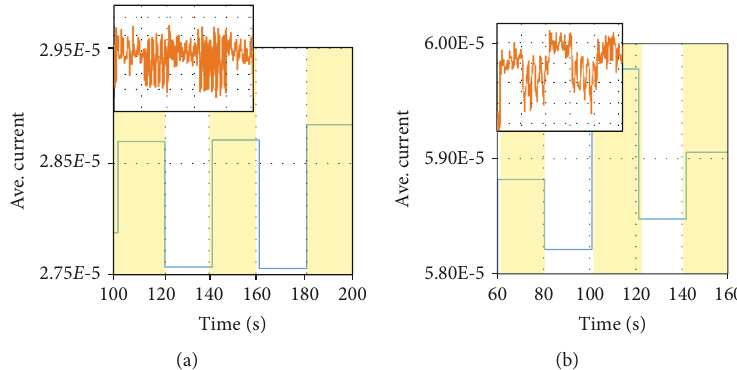
Figure 5: Oscillations in the measured current during chopped-light CA for 30V RT 450 ° C sample with polarization (a) 0V vs. Ag/AgCl and (b) 0.5V vs. Ag/AgCl (other polarization settings failed to get stable current